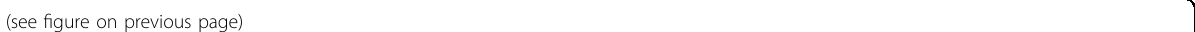
Fig. 3 Band structure, exciton funnel effect, spontaneous emission enhancement, SHG, and phase transitions in TMDCs under local strain. a Calculated band structures for nonuniformly strained monolayer MoS 2 under 0% (left panel), 2% (middle panel), and 4% (right panel) strian 41 . b Schematic of the exciton funnel effect induced by the inhomogeneous strain in a wrinkled MoS 2 region 41 . c Spatial distribution of the A exciton wavelength in a four-layer thick MoS 2 fl ake with four wrinkles 41 . d SEM micrograph of a WSe 2 monolayer conformally coated on a rough silver surface, where red dotted circles denote strained regions on silver nanoparticles 80 . e Spatially resolved and wavelength integrated (750 − 850 nm) PL intensity map of the sample in c 80 . f PL spectra taken at the locations circled in e . The spectra labeled U and B are for the pristine monolayer and bare substrate 80 . g Schematic of the SHG process in strained MoS 2 (ref. 81 ). h SHG intensity maps for monolayer (1L), bilayer (2L), and trilayer (3L) MoS 2 on a Si/SiO 2 wafer 81 . i Polarization-resolved SHG intensity patterns for a strained (red) and unstrained (blue) MoS 2 monolayer 81 . j Schematic of the strain- induced reversible phase transition in MoTe 2 (ref. 86 ). k Raman spectra taken at the suspended (red), peripheral (black), and supported (blue) areas in a cavity-supported MoTe phase, bottom panel) peaks 86 . Reprinted a – c with permission from ref. 41 . Copyright (2013) American Chemical Society. Reprinted d – f